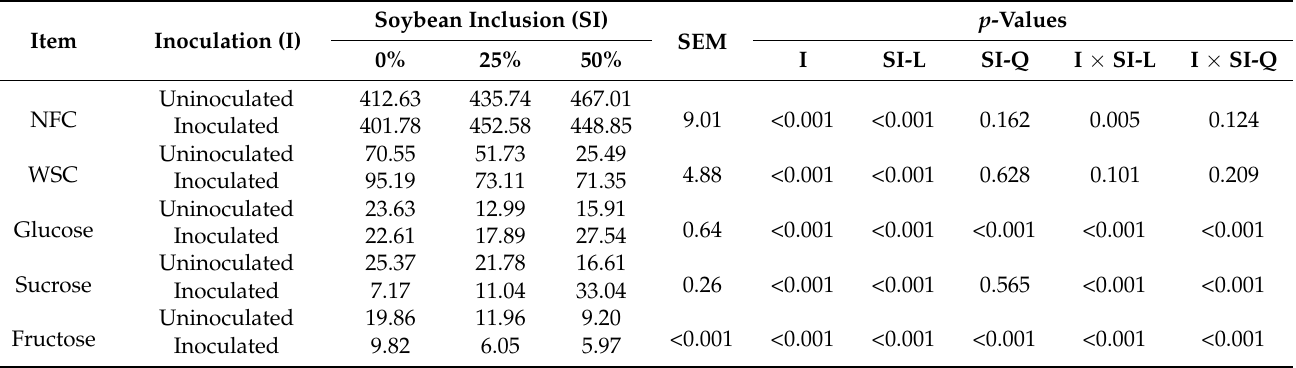
Table 4. Influence of soybean inclusion and L. plantarum A1 inoculation on NFC, WSC, glucose, sucrose and fructose in g kg − 1 DM of sorghum